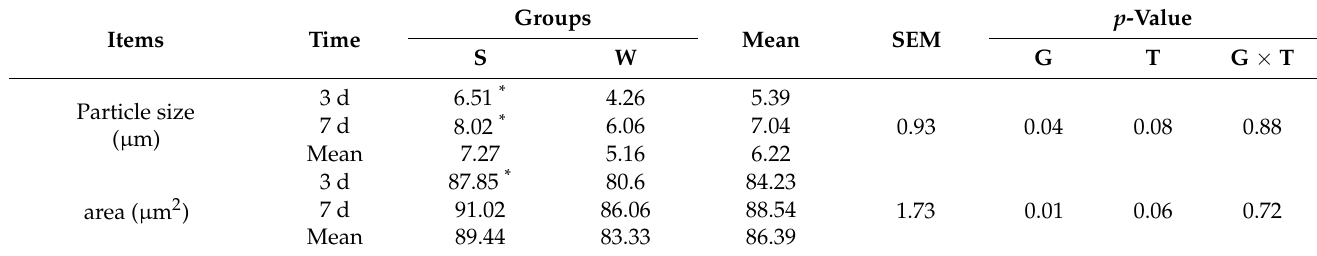
Table 4. Effects of weaning on the size and area of liver cells of piglets.